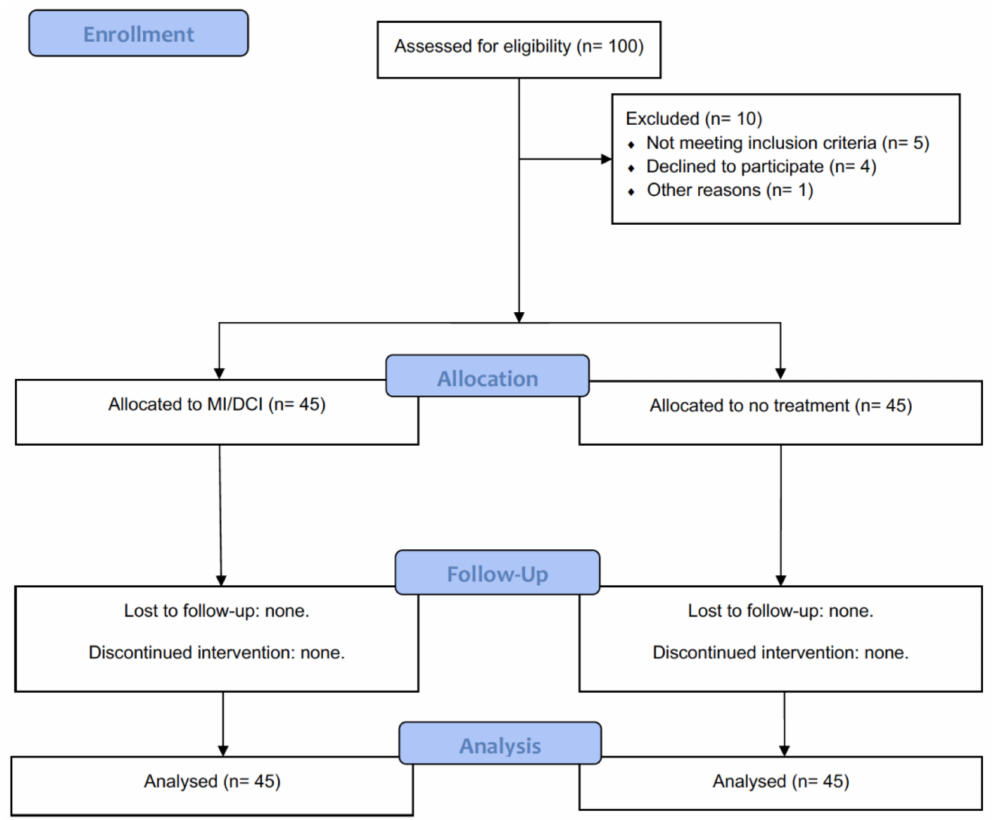
Figure 1. Flow-chart for inclusion and treatment of long-term survivors of lymphoma. MI/DCI: Myo-Inositol and D-Chiro-Inositol oral